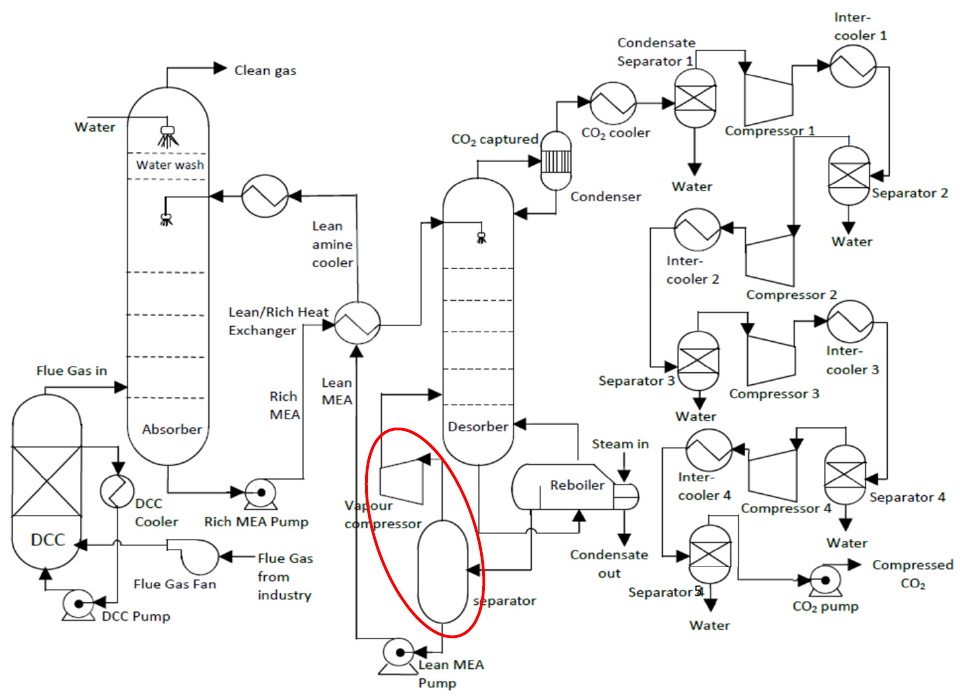
Figure 2. Lean vapour compression (LVC) configuration CO 2 capture process (modified from [3]). (the red line is to highlight the additional equipment)